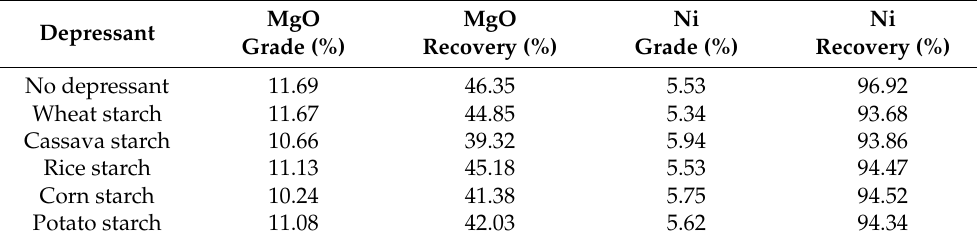
Table 2. Flotation separation of mixed mineral with different causticized starch depressants.